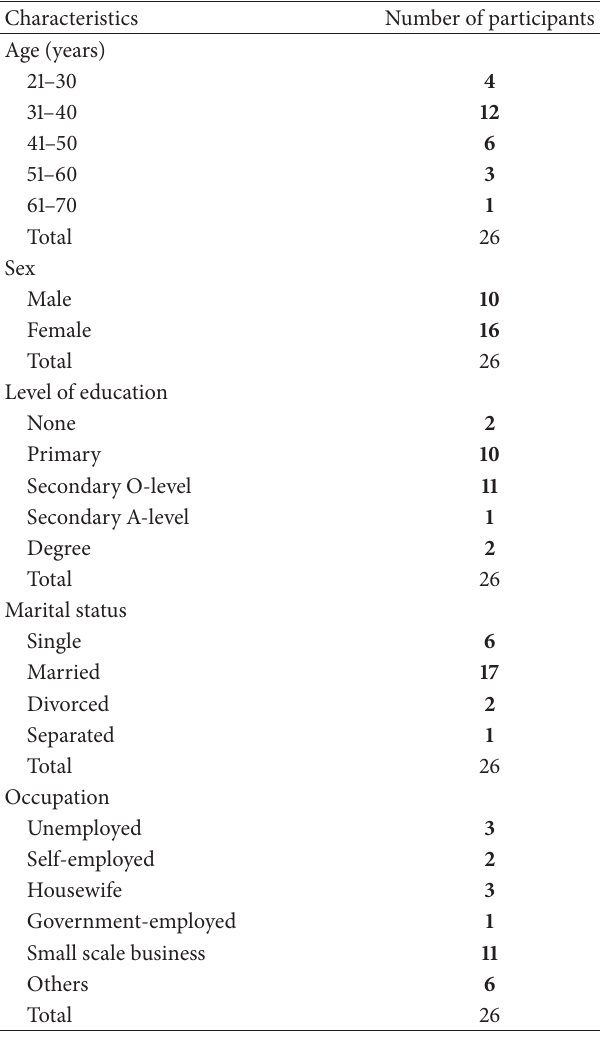
Table 1: Summary of sociodemographic characteristics of study